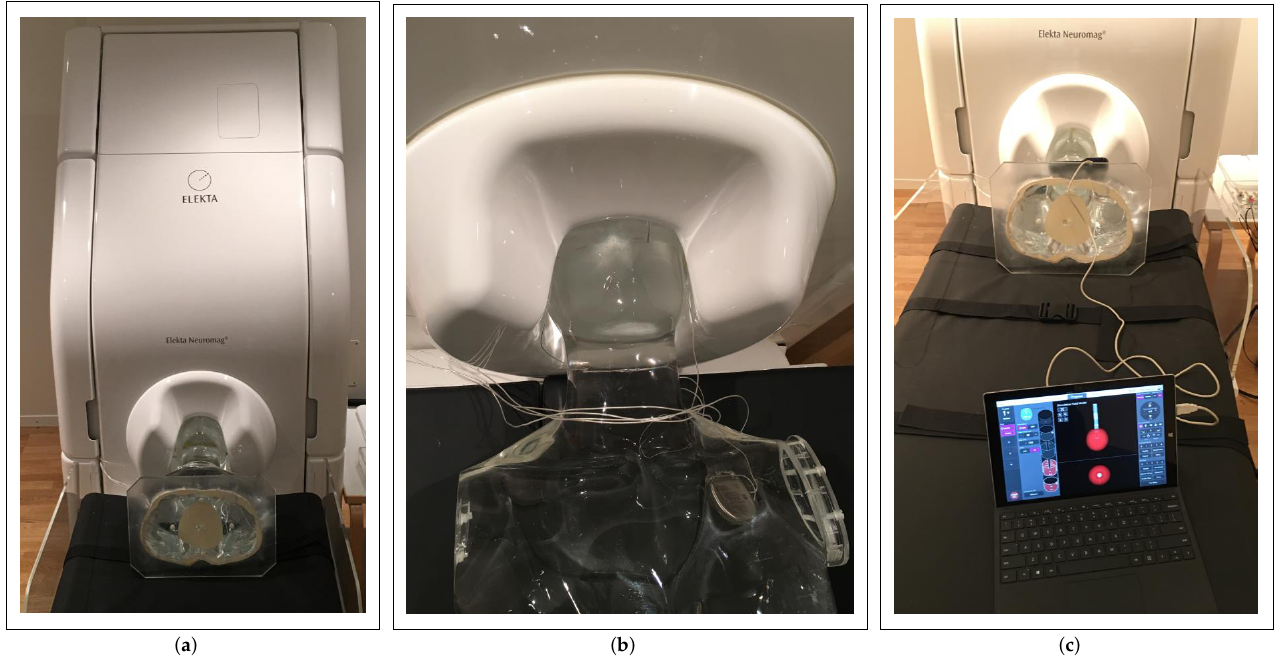
Figure 4. ( a ) Phantom placed on patient bed in the MEG scanner. ( b ) Phantom head within the MEG sensor array. Lower part of the electrode, IPG, and coil cables are visible. ( c ) Programming of the IPG using a programming